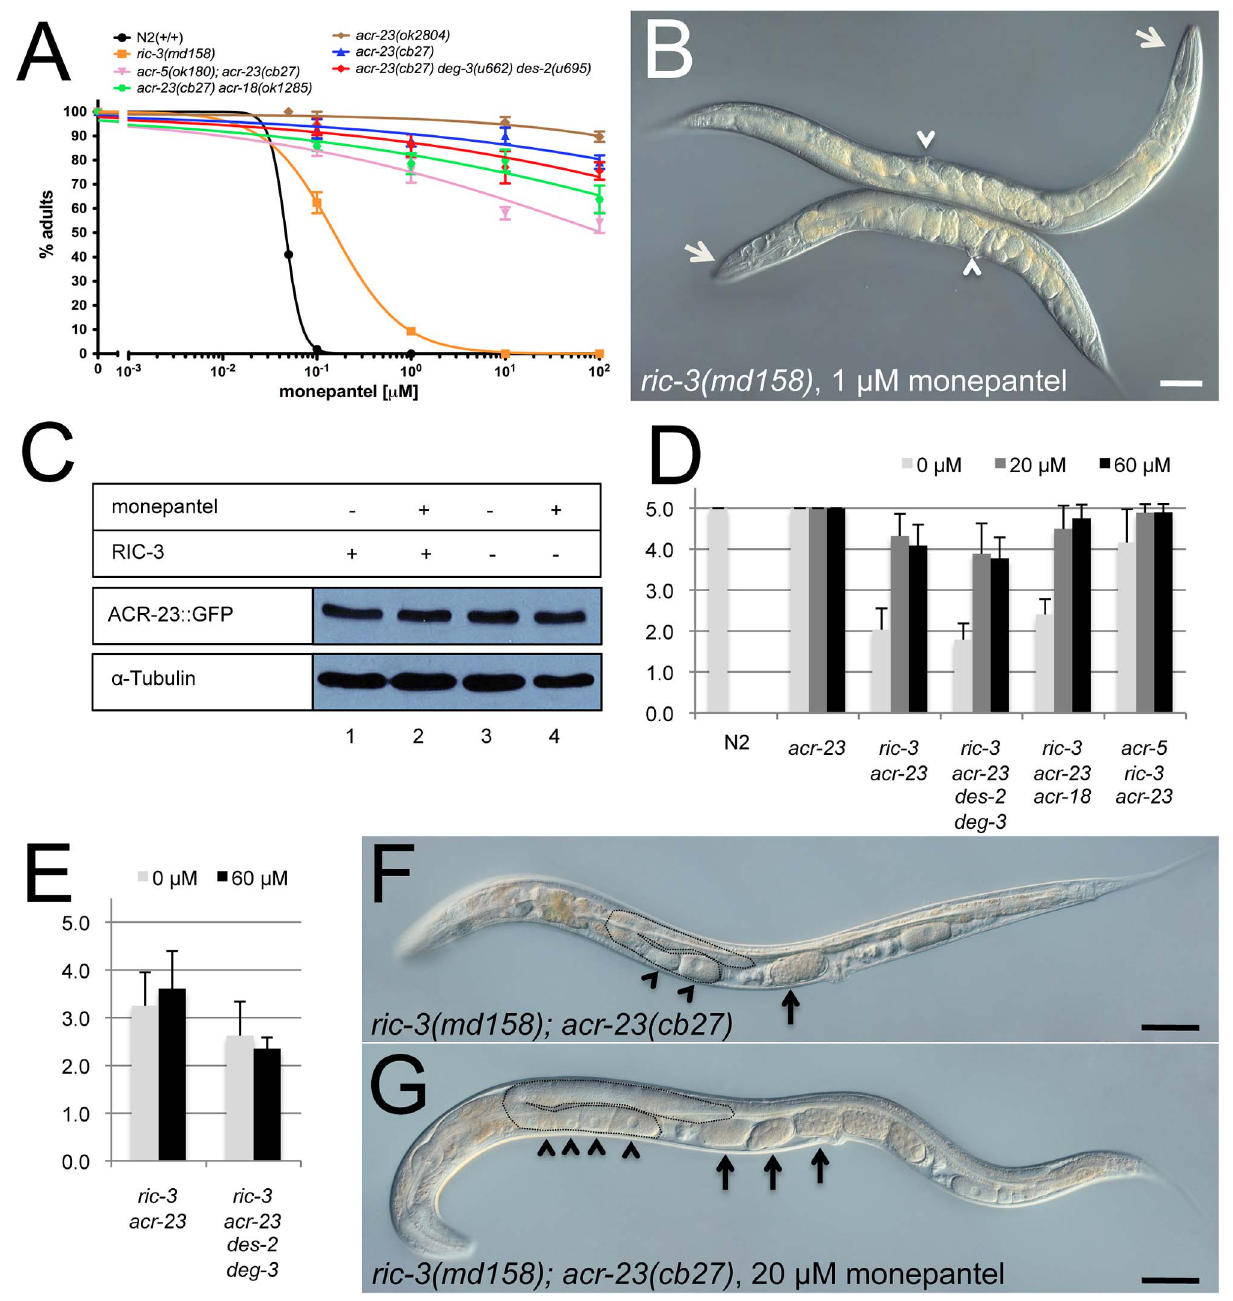
Figure 5. Effect of ric-3 on the response to monepantel. A) Dose response to monepantel. The average number of progeny reaching adulthood after 3 days is plotted versus the concentration of monepantel. ric-3(md158) mutants are partially resistant to low doses of monepantel. B) ric- 3(md158) adult grown on 1 m M monepantel (bottom) compared to a sibling grown in absence of the drug (top). The reduced length is certainly caused by muscle contraction due to monepantel. White arrows and arrowheads point at the heads and vulvae, respectively. C) ACR-23::GFP protein levels in wild-type (lanes 1,2) and ric-3 (lanes 3,4) animals after 2 hours of exposure to 10 m M monepantel (lanes 2,4). a -Tubulin was used to verify equal loading. D) Growth of wild-type and mutant strains on monepantel. Light gray (0 m M), dark gray (20 m M) and black (50 m M) bars represent the growth rate after 9 days of culture. In the absence of monepantel, wild-type (N2) worms grow much faster than any of the mutants tested. Genotypes are indicated. Values for growth rates are defined in the methods section (1, poor growth; 5, robust growth). acr-23 single mutants grew to level 5 in less than 5 days, whereas ric-3; acr-23 double mutants reached level 2 in absence of monepantel, and level 4 in presence of the drug. E) Growth rates after 9 days on the inactive R-enantiomer of monepantel. F) ric-3(md158); acr-23(cb27) adult grown in absence of monepantel. G) Adult ric-3(md158); acr-23(cb27) sibling grown on 20 m M monepantel. In both panels (F and G), one germline arm is outlined. Arrowheads and arrows point at oocytes and early embryos, respectively. The outlined germline arm shows robust production of gametes (panel G). Scale bar, 50 m m.